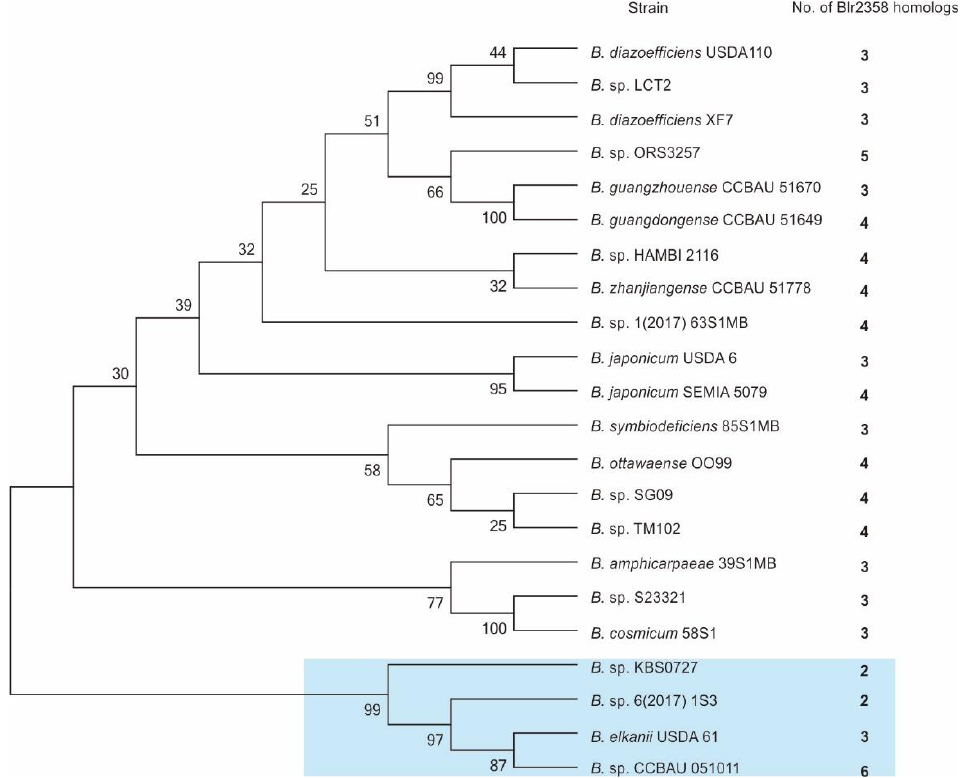
Figure 3. Representative Blr2358 homologs in the Bradyrhizobium genus. A phylogenetic tree was made with MEGA6 software using the neighbor-joining method and 16S rDNA sequences from representative Bradyrhizobium strains. The number of Blr2358 homologs in each strain is shown. The blue rectangle indicates the clade of Bradyrhizobium strains that possess relatively low amino acid sequence similarities to Blr2358.